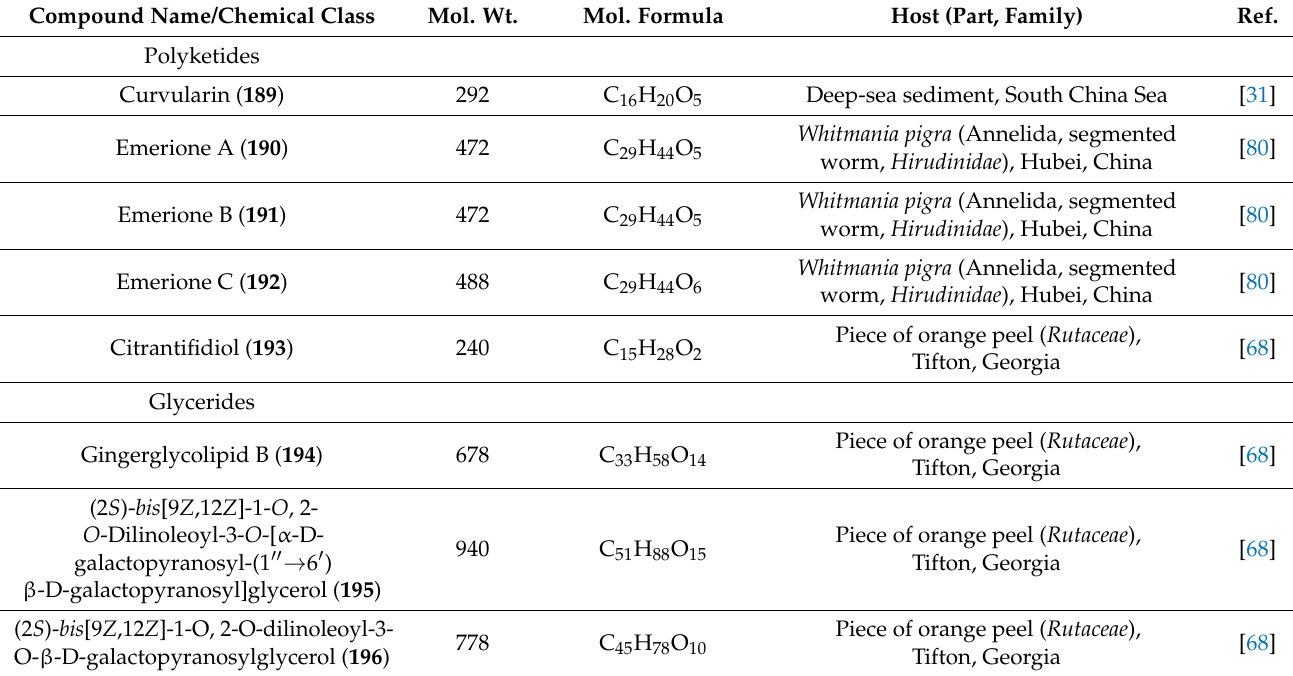
Figure 19. Structures of polyketides ( 189 – 193 ) and glycerides ( 194 – 196 ). Table 13. Polyketides and glycerides reported from A. nidulans .